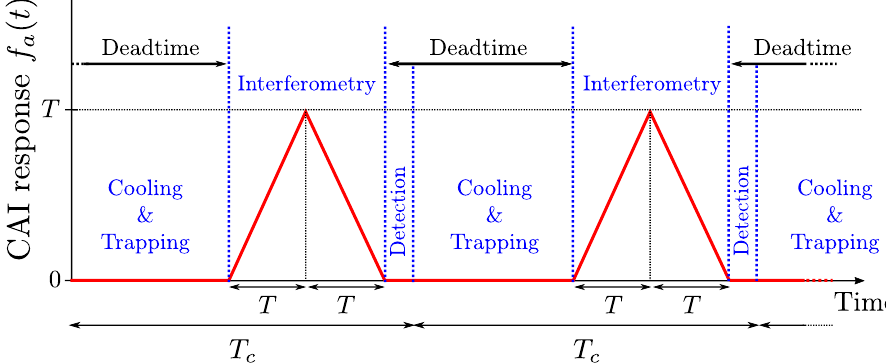
Figure 2. Typical atom interferometer sequence. After cooling and trapping the atoms, the interfer- ometer is realized with a total duration time 2 T . The phase at the output of the interferometer is measured during the subsequent detection phase. The measurement is given with a cycling time T c . The atomic instrument is only sensitive to acceleration during the interferometer